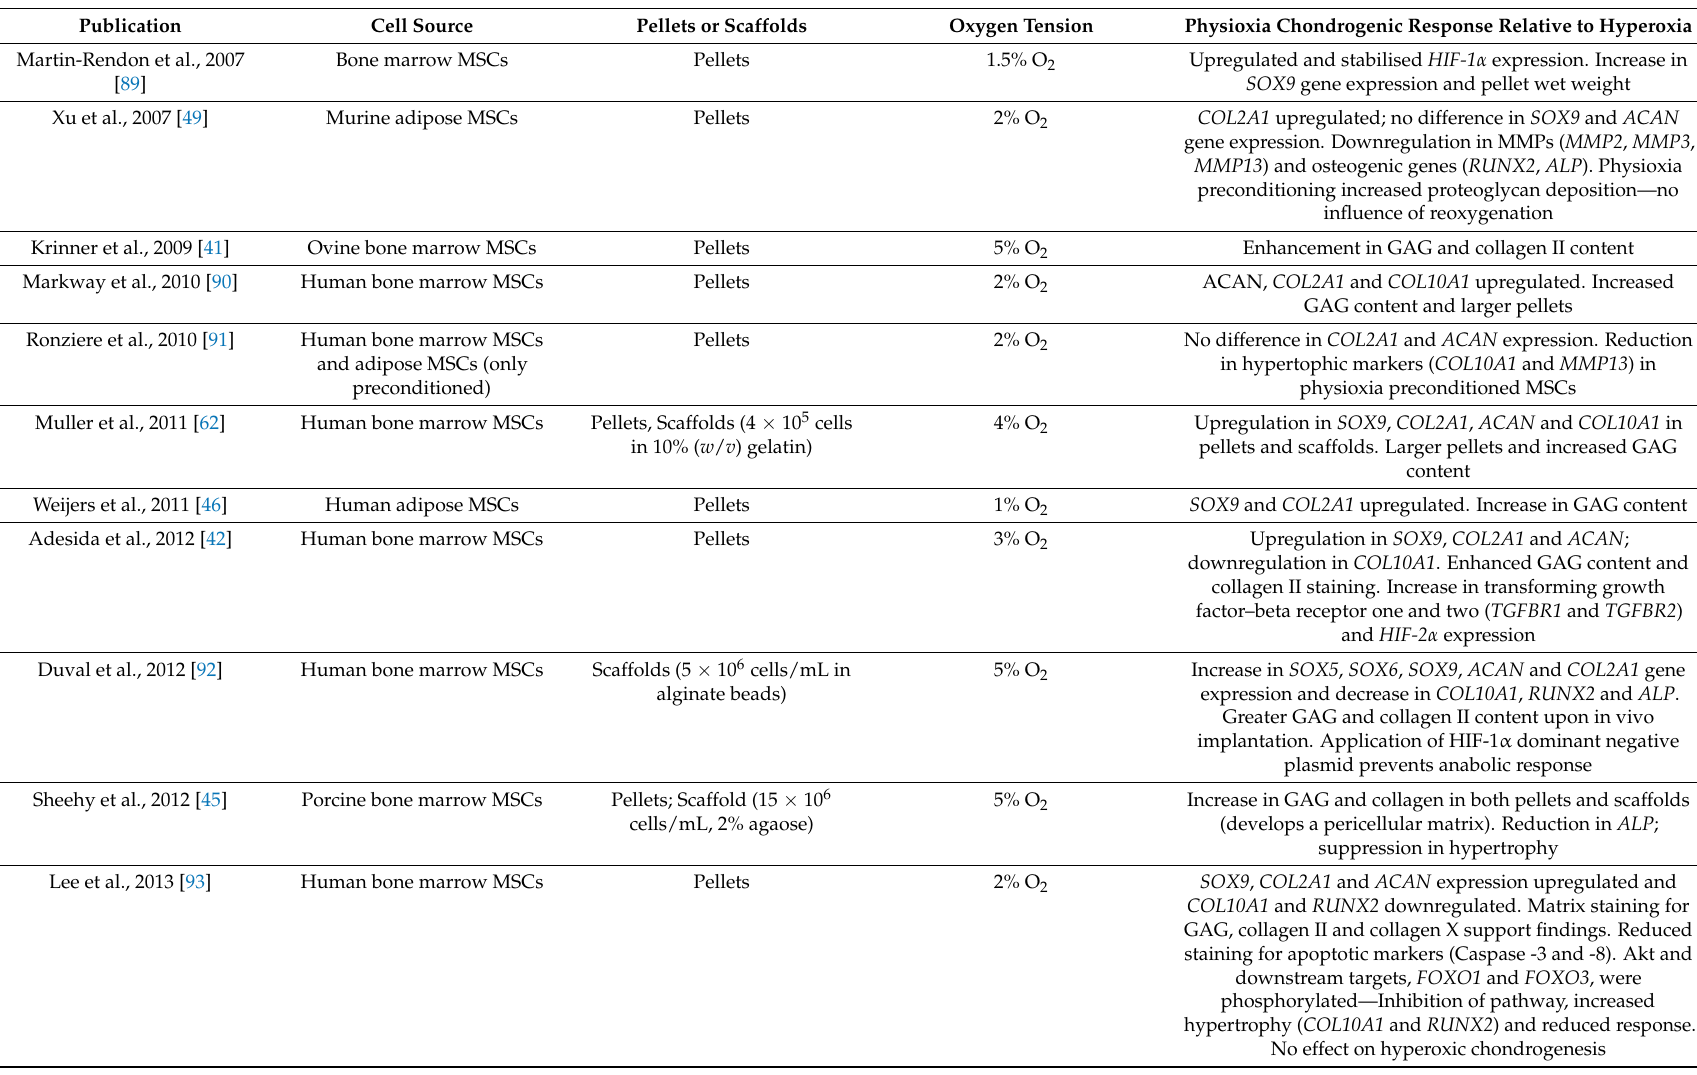
Table 2. Summary of key findings from publications examining the effect of physioxia preconditioning on MSC chondrogenesis. Findings are relative to